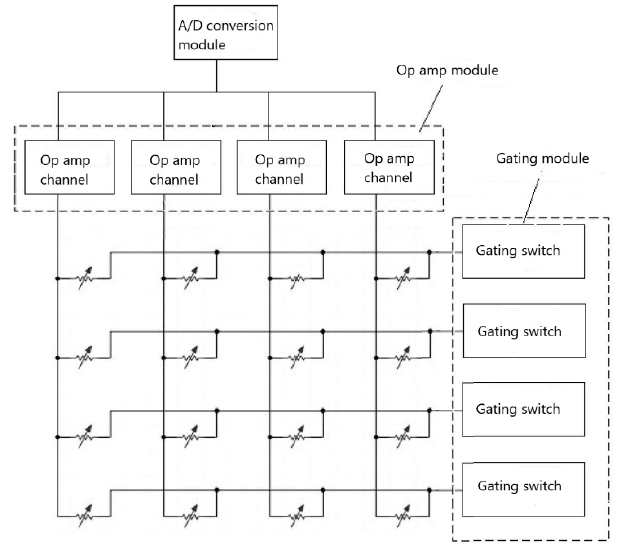
Figure 4. Schematic diagram of the arrangement of the pressure sensor elements (here, 4 × 4 is used to indicate the 16 × 16 original circuit).